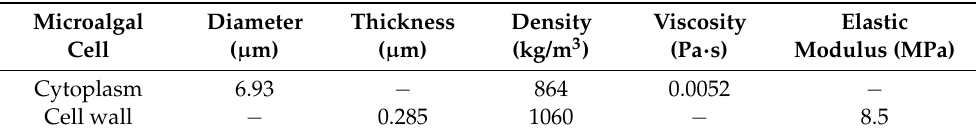
Table 1. Properties of microalgal cells used in the